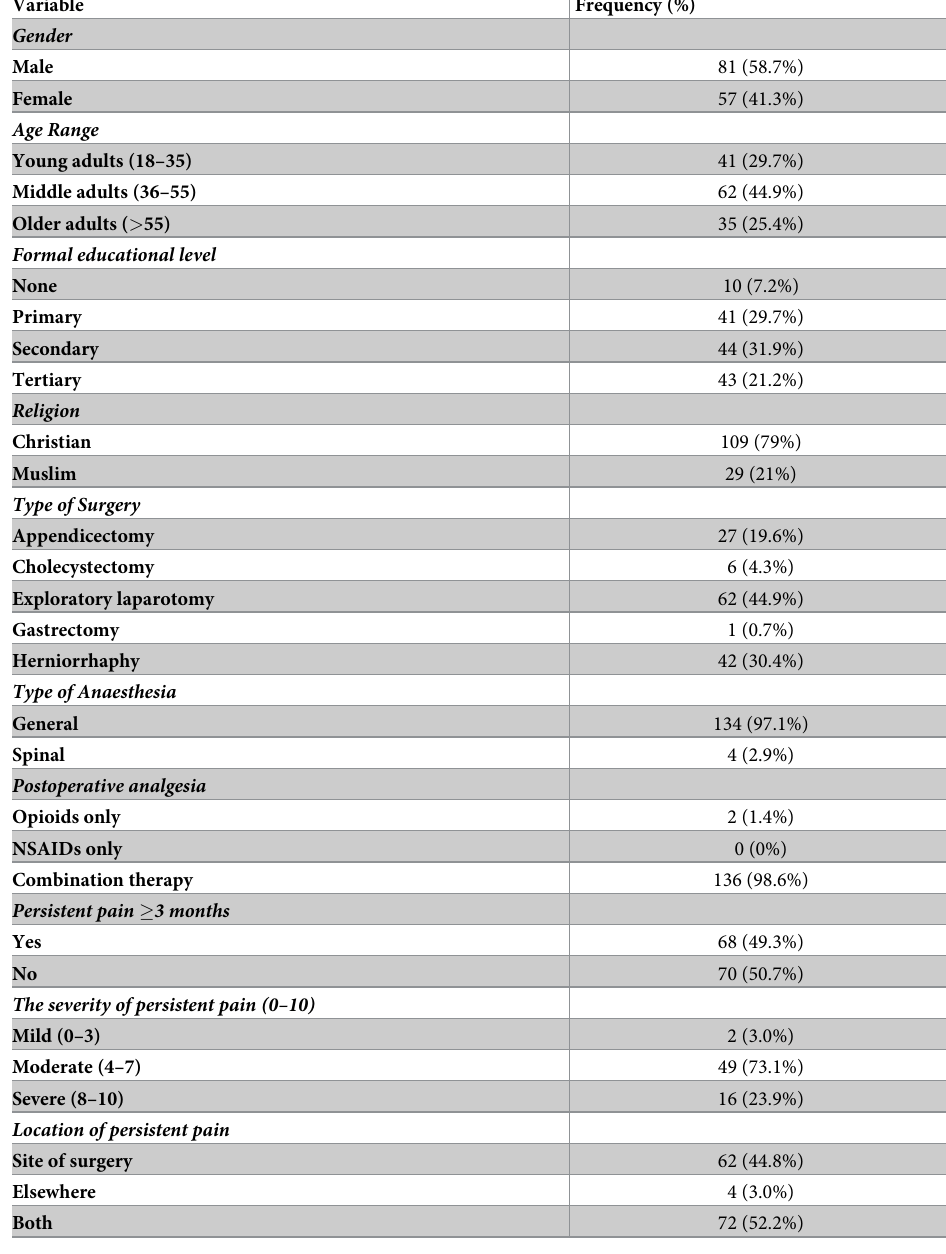
Table 1. Demographics and procedural characteristics of participants (n =